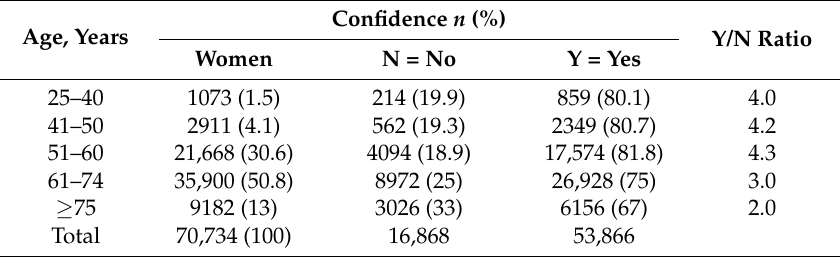
Table 5. Confidence as a function of